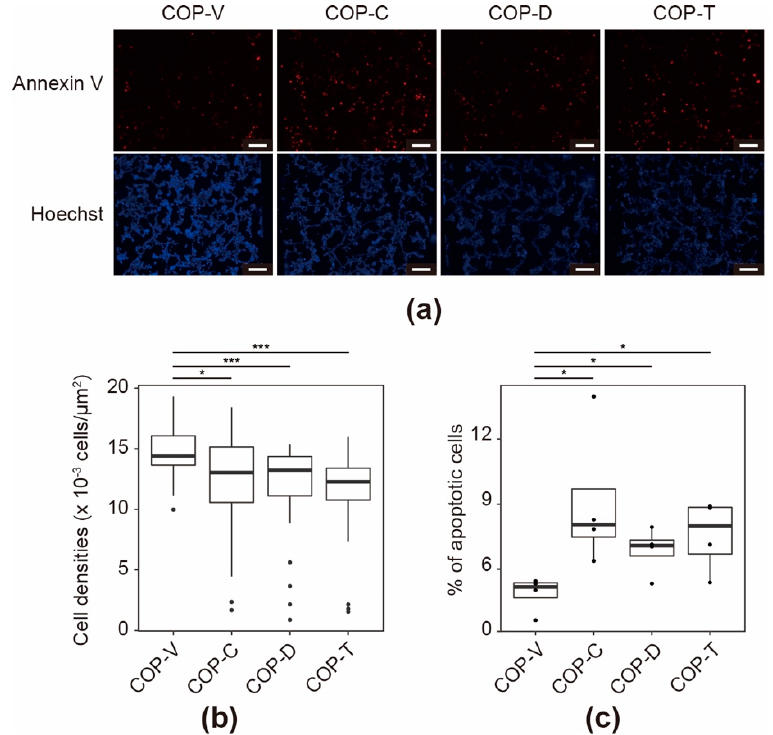
Figure 10. Evaluation of apoptotic cells cultured in cyclo-olefin polymer (COP) devices prepared by vacuum ultraviolet (VUV)-photobonding (COP-V) or solvent-bonding with cyclohexane (COP-C), toluene (COP-T), or dichloromethane (COP-D). ( a ) Fluorescence micrographs of SH-SY5Y neuroblastoma cells stained with Annexin V-Alexa 594 apoptotic marker. SH-SY5Y cells were cultured in Matrigel-coated COP devices for four days and then stained with fluorescent dyes. Hoechst 33258 (Hoechst) was used as the fluorescent dye to visualize the cell nuclei. Scale bars: 100 µm. ( b ) Cellular densities after four days of culturing in the COP devices, as determined by counting the nuclei. ( c ) Percentage of apoptotic cells after four days of culturing in the COP devices, as determined from the Annexin V-Alexa 594 positive cells (Figure S4 in the Supplementary Materials). The center lines represent the median values; the box limits indicate the 25th and 75th percentiles; the whiskers extend to 1.5-times the interquartile range from the 25th and 75th percentiles; and outliers are represented by dots. Each experiment was repeated four times, and more than ten images of the COP devices from each experiment were used for quantification. * p < 0.05, *** p < 0.005.